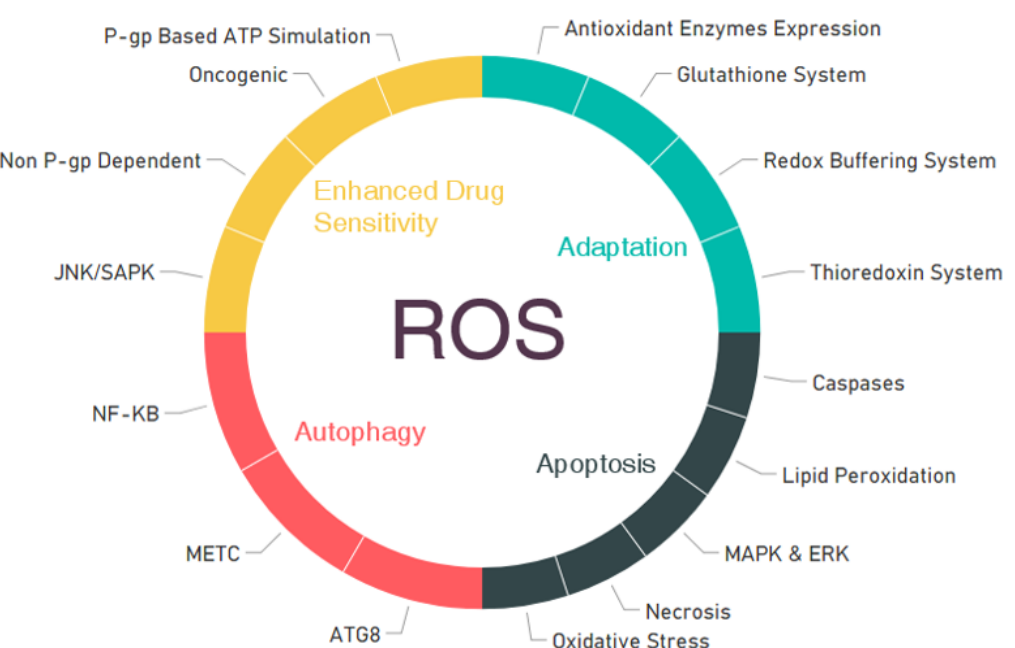
Figure 3. Role of reactive oxygen species (ROS) in cancer inhibition by four different mechanisms and the different pathways involved in those mechanisms.